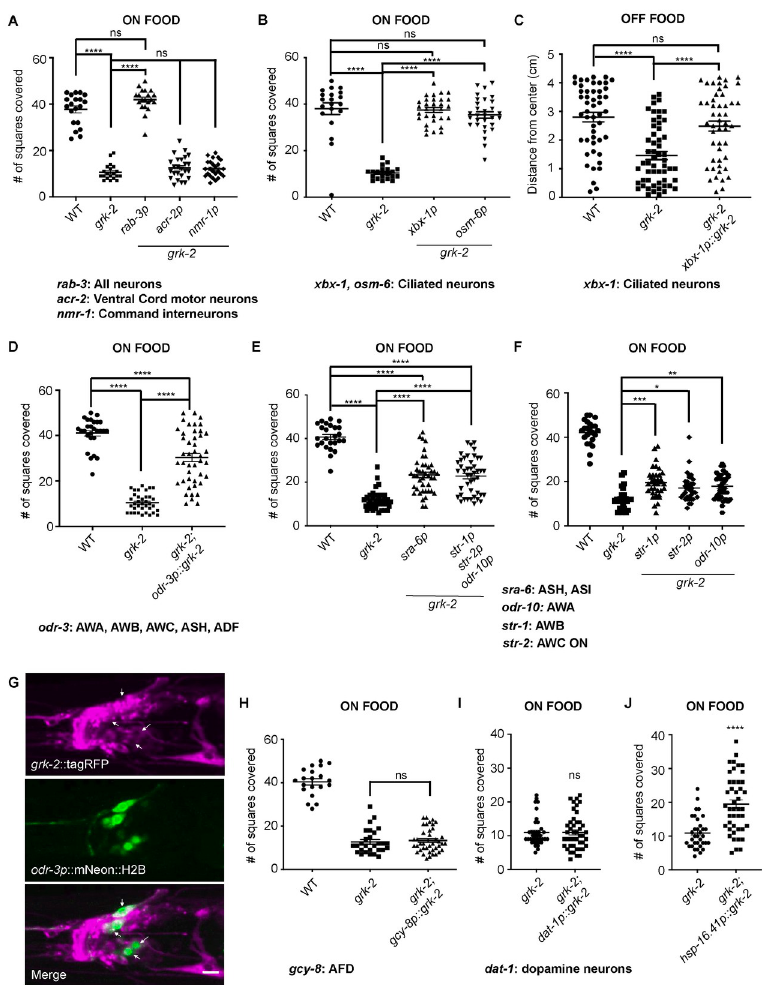
Fig 2. grk-2 acts in the ciliated neurons to control exploration behavior. (A) Expression of grk-2 cDNA under a pan- neuronal promoter rescues the exploration defect of grk-2 mutant animals in the presence of food. The grk-2 cDNA was expressed in grk-2(gk268) mutant animals under a pan-neuronal promoter ( rab-3p , transgene yakEx44 ), ventral cord acetylcholine motor neuron promoter ( acr-2p , transgene yakEx47 ), and interneuron promoter ( nmr-1p , transgene yakSi32 ). Shown is the number of squares single animals covered in ~20 h. ( ���� , P < 0.0001. ns, P > 0.05. One way ANOVA followed by a Bonferroni test. Error bars = SEM; n = 20–25). (B) Expression of grk-2 cDNA under either of two ciliated sensory neuron promoters ( xbx-1p , transgene yakEx71 and osm-6p , transgene yakEx53 ) rescues the exploration defect of grk-2(gk268) mutant animals in the presence of food. ( ���� , P < 0.001. ns, P > 0.05. One way ANOVA followed by a Bonferroni test. Error bars = SEM; n = 20–30). (C) Expression of grk-2 cDNA under a ciliated sensory neuron promoter ( xbx-1p :: grk-2 , transgene yakEx71 ) rescues the dispersal defect of grk-2(gk268) in the absence of food. ( ���� , P < 0.0001. ns, P > 0.05. One way ANOVA followed by a Bonferroni test. Error bars = SEM; n = 49–55). Please note the high variability in the off-food response in comparison to the on-food response (Fig 2B). This could be because worms are more mobile in the absence of food and constantly searching for a food source, which would increase the variability of the distances they cover. (D) Expression of grk-2 cDNA under the odr-3 promoter (expression in AWA, AWB, AWC, ASH, and ADF neurons; odr-3p :: grk-2 , transgene yakEx189 ) partially rescues the exploration defect of grk-2(gk268) . ( ���� , P < 0.0001. One way ANOVA followed by a Bonferroni test. Error bars = SEM; n = 27–44). (E) Expression of grk-2 cDNA under the sra-6 promoter (expression in ASH and ASI neurons; sra-6p :: grk-2 , transgene yakEx191 ) or under the combined control of the odr-10 (AWA neurons), str-1 (AWB neurons) and str-2 (AWC ON neuron) promoters ( str-1p , str-2p , odr-10p :: grk-2 , transgene yakEx194 ) partially rescues the exploration defect of grk-2(gk268) . ( ���� , P < 0.0001. One way ANOVA followed by a Bonferroni test. Error bars = SEM; n = 25–44). (F) Expression of grk-2 cDNA under the odr-10p (AWA), str-1p (AWB), or str-2p (AWC ON) promoters (transgenes pekEx267 , pekEx265 and pekEx266 , respectively) partially rescues the grk-2 exploration defect. ( ��� , P < 0.001. �� , P < 0.01. � , P < 0.05. One way ANOVA followed by a Bonferroni test. Error bars = SEM; n = 20–33). Twenty of the data points shown for WT and grk-2 mutant are the same as in Fig 3B (these experiments were run